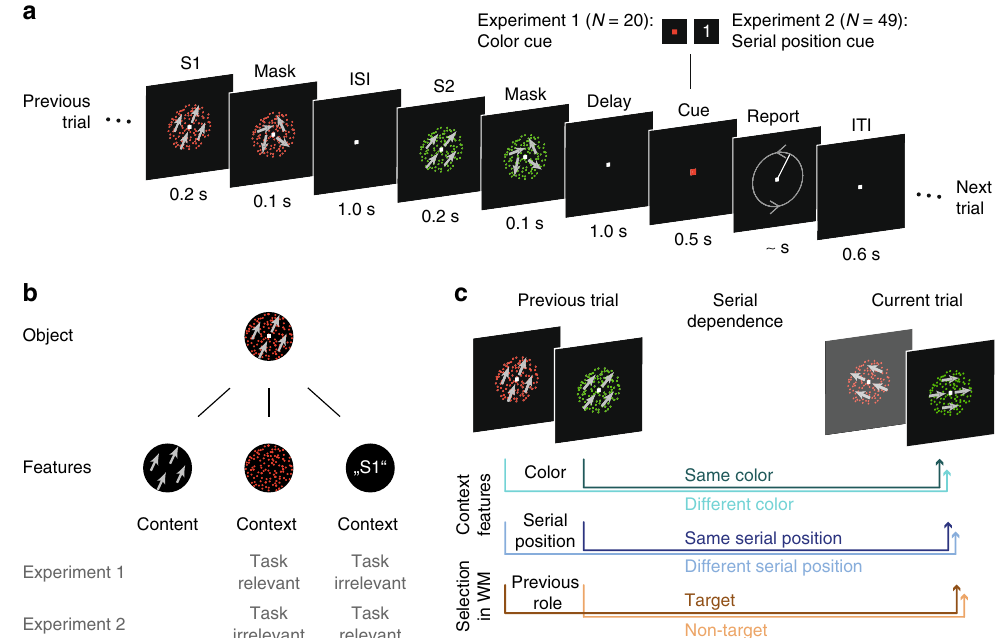
Fig. 1 Experimental paradigm and object de fi nition. a In every trial, participants had to memorize motion directions (indicated here by gray arrows for illustration only) of two sequentially presented dot fi elds (S1 and S2) and report one of them after a short delay by adjusting the orientation of a line (possible adjustment directions indicated here by gray arrows for illustration only). The to-be-reported target item was cued via color (Experiment 1) or via serial position (Experiment 2). b Every object can be de fi ned regarding its content feature, here motion direction of 25°, and regarding its context features, here color (red) and serial position ( fi rst in the sequence, S1). The context feature by which targets were cued was the task-relevant feature, whereas the other feature was task-irrelevant (e.g., color and serial position in Experiment 1, respectively). c We assessed the effects of three factors on the response error for a cued item (target) in the current trial: color (same or different), serial position (same or different) and role (target or non-target) of an item in the previous